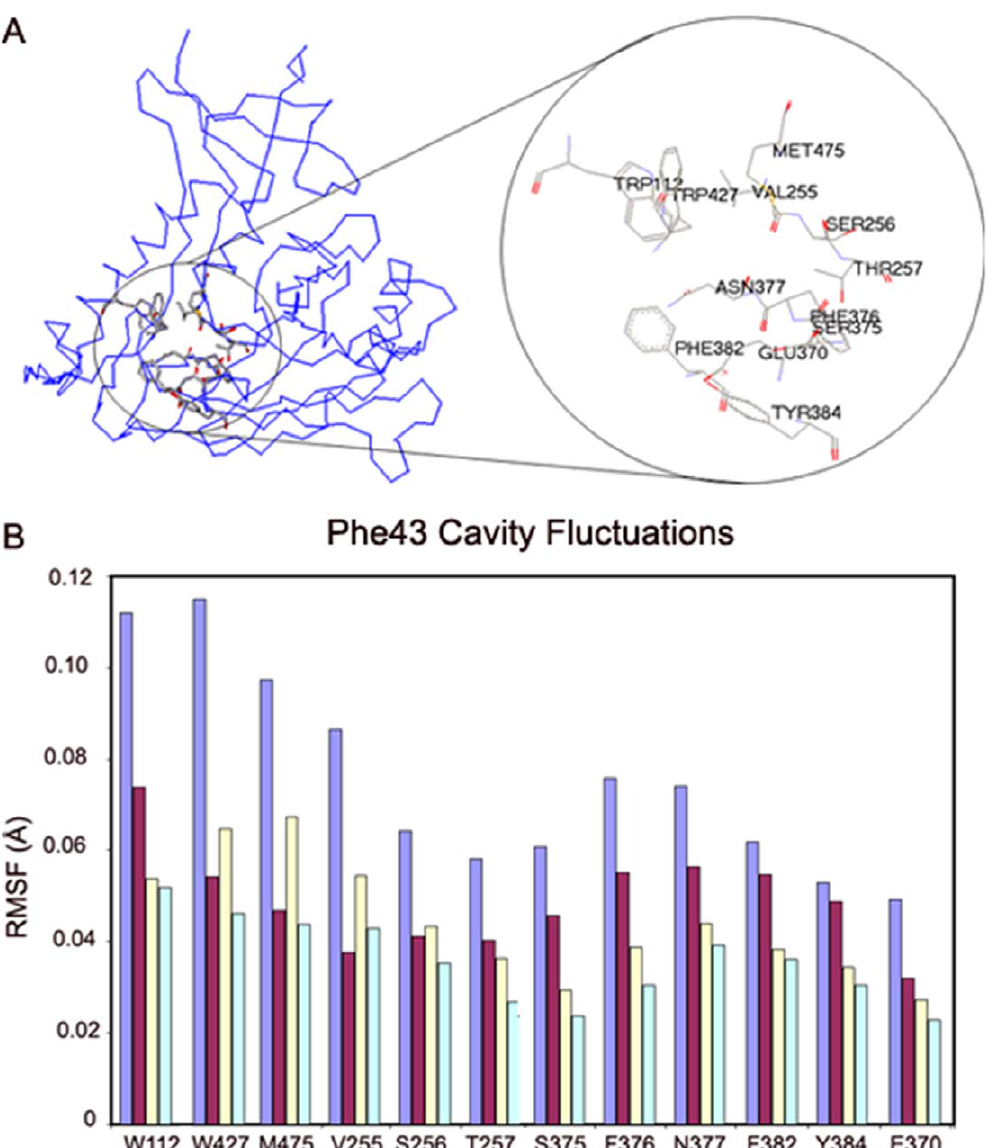
Figure 7. Fluctuations of Phe43 cavity residues. ( A ) Identification of residues that line the Phe43 cavity in HIV gp120. The point of view is as in Fig. 1A, but rotated clockwise about the page normal by approximately 40 u . ( B ) RMS residue fluctuations of Phe43-cavity lining residues as driven by the linear combination of the 10 slowest modes from full atomic normal mode analysis. Values are shown in bars for the identified residues from isolated gp120 (light blue) and for gp120 complexed with CD4 D1 (burgundy), F23 (pale yellow) and CD4M33 (pale turquoise). Residues are placed in neighboring order, starting from W112 at upper left and moving roughly clockwise as viewed in Fig. 7A.